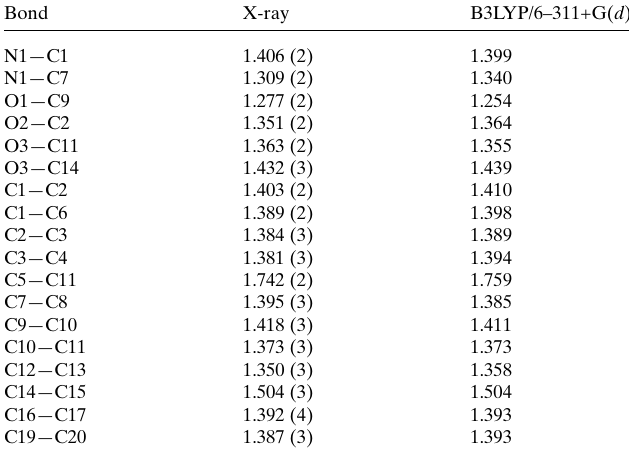
Table 3 Experimental and calculated bond lengths (A˚ ) for compound (II).